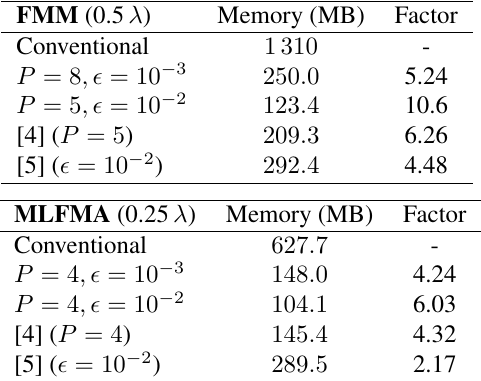
plate with an edge length of a = 32 λ and a = 64 λ , respectively. In both cases the plate is discretized with 1 085 544 basis functions. Computational results for a con- ventional approach, the proposed technique with P = 4 and (cid:15) = 0 . 01 as well as a pure spherical harmonic repre- sentation with P = 4 are given in Table 4. The